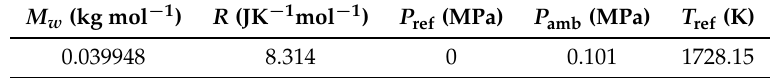
Table 2. Parameters used for modeling gas inside pores. The gas considered for simulations is